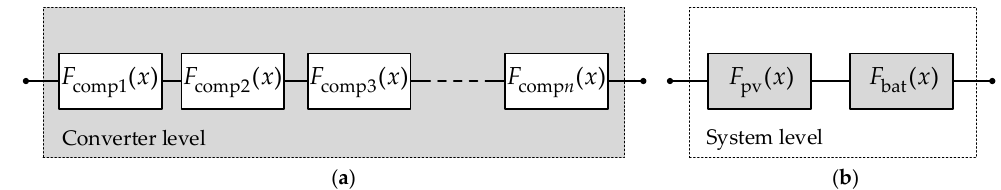
Figure 11. Series connection of the reliability block diagram: ( a ) converter level and ( b ) system level, where F comp i ( x ) represents the unreliability function of the i th device in the converter, and F pv ( x ) and F bat ( x ) represent the unreliability functions of the PV and battery converters,